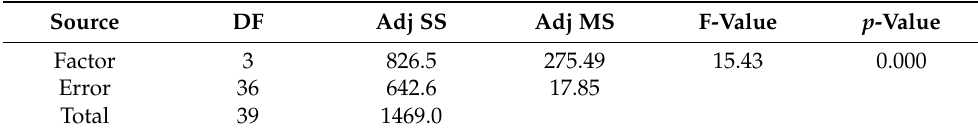
Table 6. Analysis of